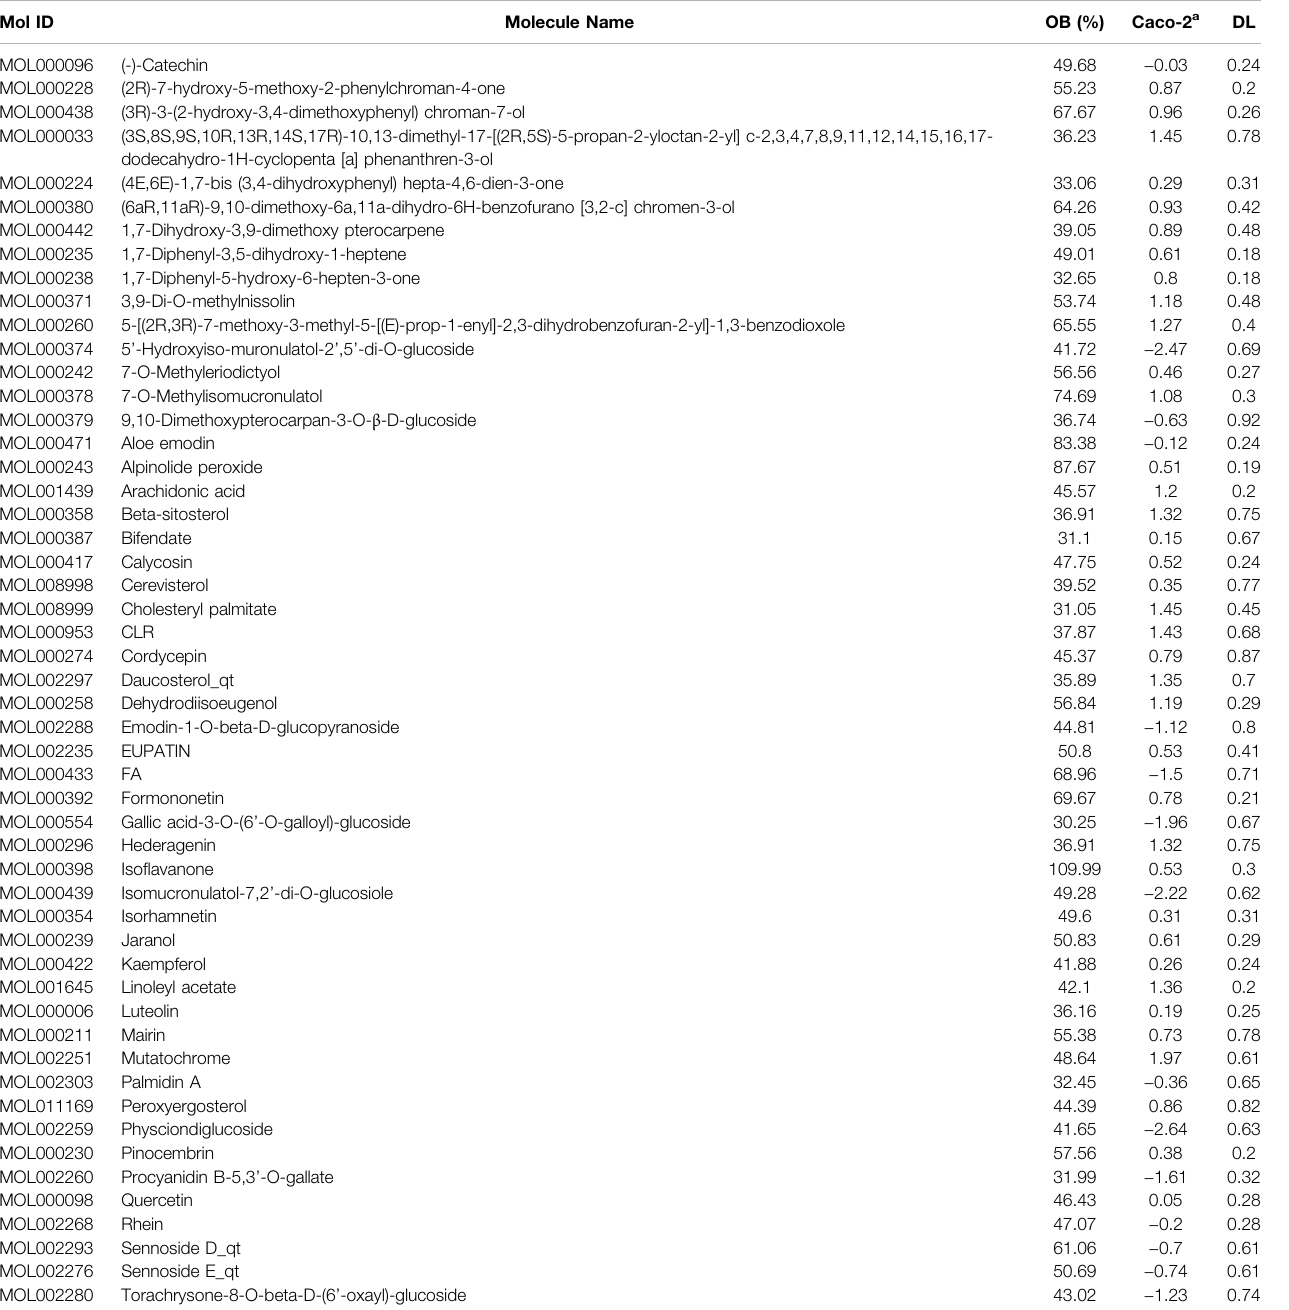
TABLE 2 | Biological active ingredients in